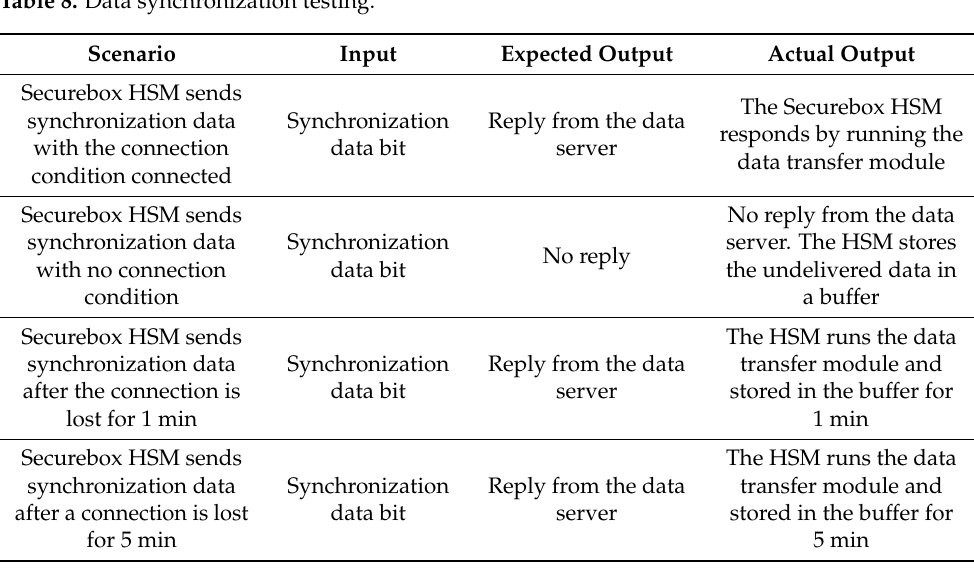
Table 8. Data synchronization testing.